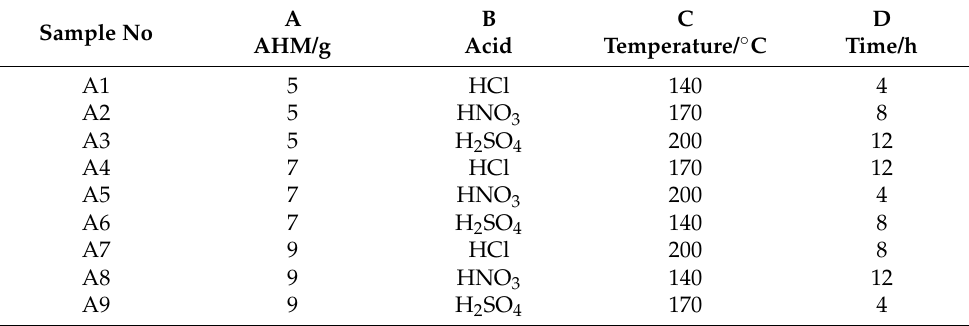
Table 2. Orthogonal test table L9 (3 4 ).